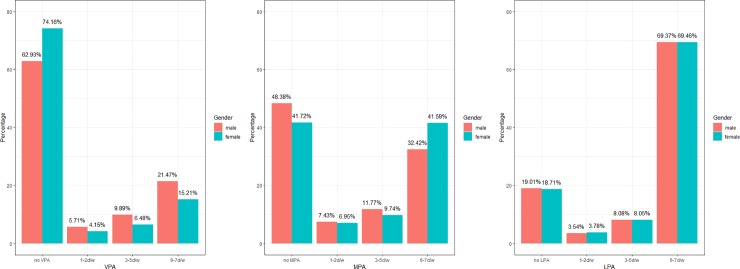
Frequency of VPA, MPA and LPA in men and women.